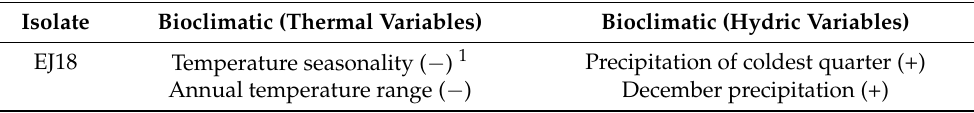
Table 4. Ecogeographical variables ordered according to their significant differences ( p <